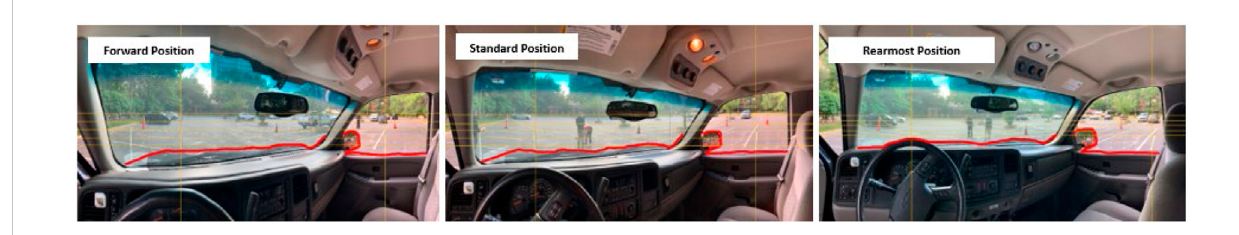
FIGURE 3 Panoramic picture taken in the forward, standard and rearmost seating